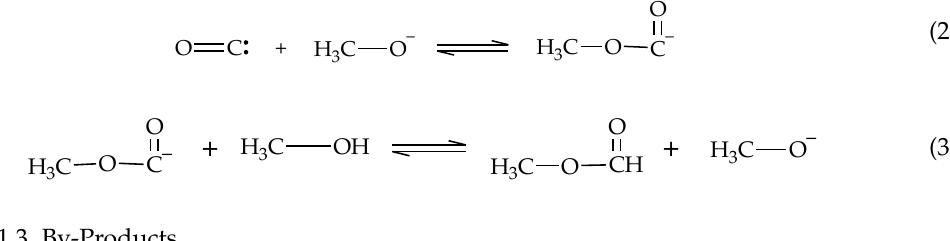
A possible side reaction is the formation of DME (Equation (4)) and TME (Equations (5) and (6)) by reaction of methoxide with MF. Furthermore, reactions of sodium methoxide with traces of water and CO 2 (Equations (7)–(9)) are possible and form insoluble sodium methoxycarboante